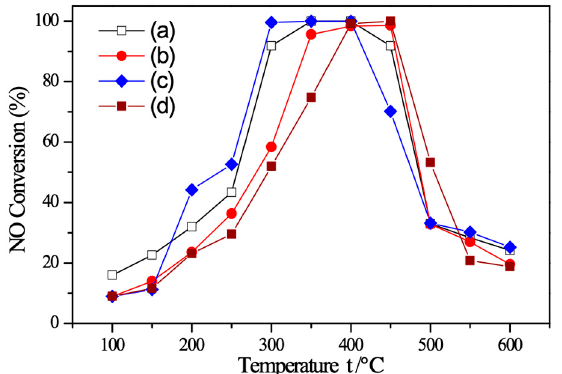
Figure 8. NO conversion over Fe/Beta(LIE) catalysts. Reaction conditions: ( a ) 0.05 NO, 0.05% C 3 H 6 , 2% O 2 , ( b ) 0.05 NO, 0.05% C 3 H 6 , 2% O 2 , 0.02% SO 2 , ( c ) 0.05 NO, 0.05% C 3 H 6 , 2% O 2 , 5% H 2 O, and ( d )